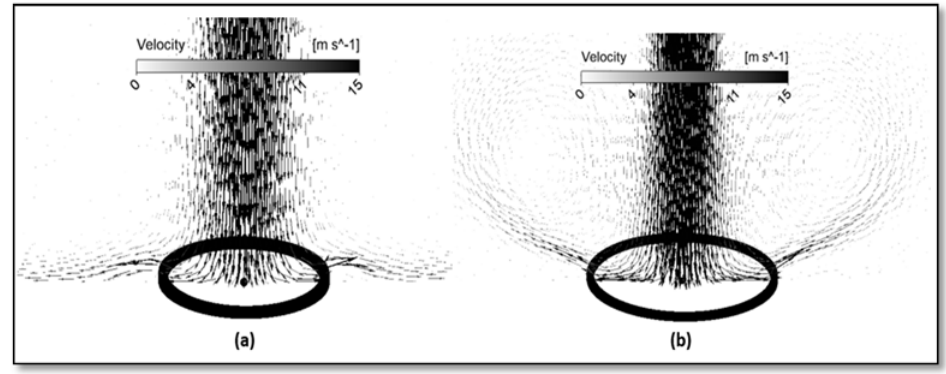
Figure 9. Velocity vectors for e = 1.5 mm. ( a ) R/D = 1 and ( b ) R/D = 1.5.